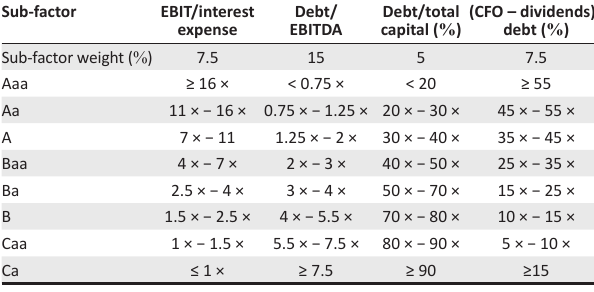
TABLE 4: Detail of Factor 4 (leverage and coverage) of Moody’s mining methodology.